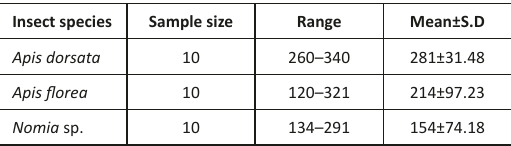
Table 1. Results of breeding experiments on Scyphiphora